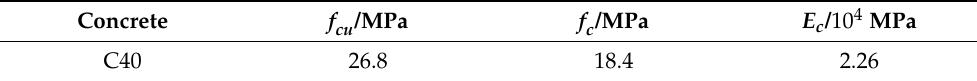
Table 2. Material properties of concrete.